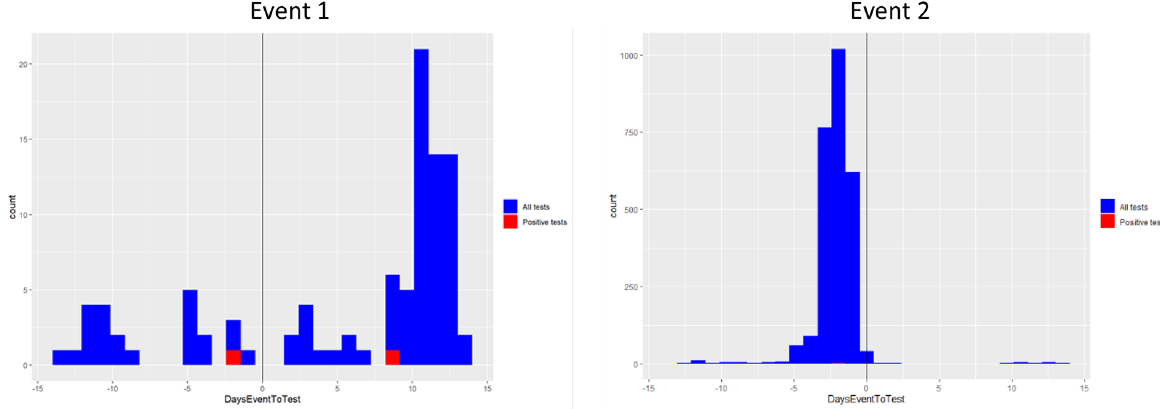
Figure 2: SARS-CoV-2 tests by date sample taken, in the period 14 days before to 14 days after each event